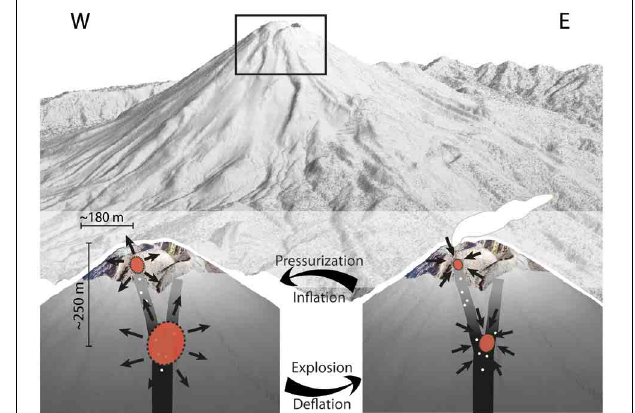
FIGURE 6 | Geocoded photograph of the summit taken on January 10th during an airplane overflight. The circular markers show the approximate projected locations of the upper source (in orange) and the lower source (in green), as well as their approximate extents. The white arrow points to the location of the new extrusion, located at the center of the crater left by the January 6th explosion. This extrusion was removed by the following explosion on January 11th.